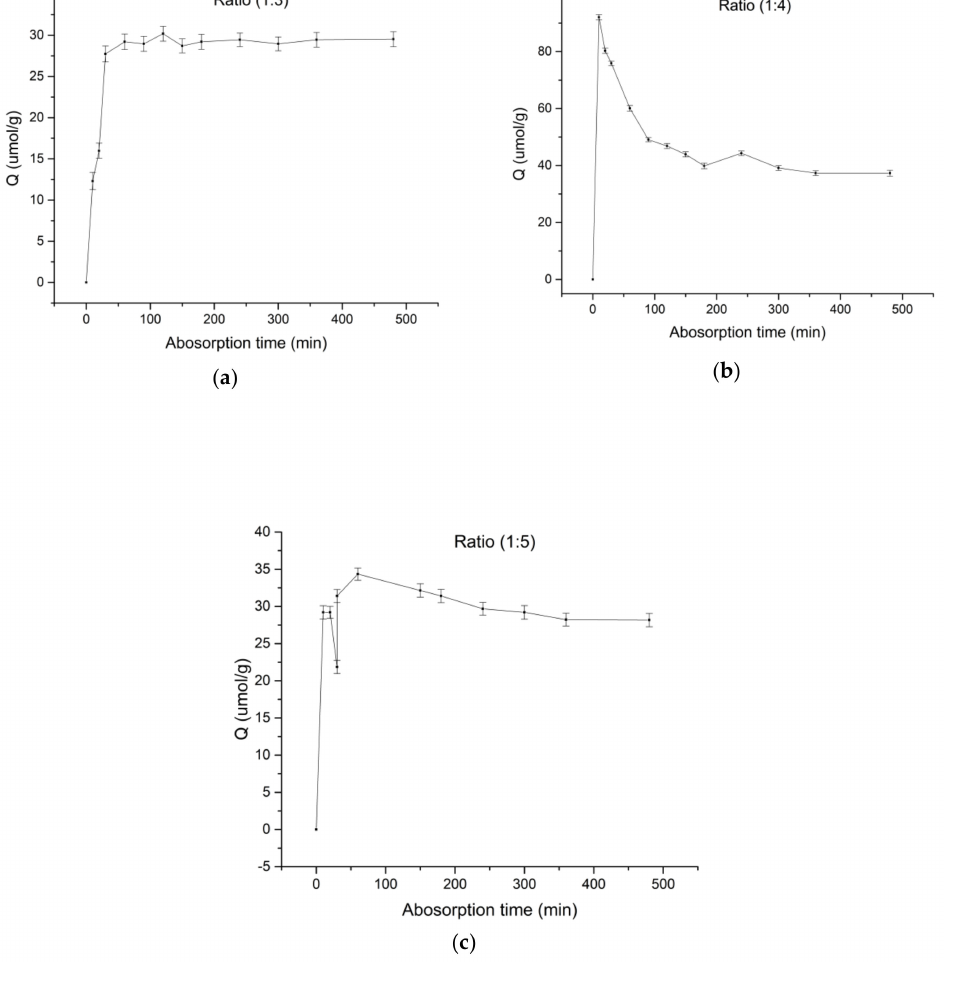
Figure 2. Curves of the binding dynamics of the three MIPs. ( a ) Ratio = 1:3, ( b ) ratio = 1:4, ( c ) ratio = 1:5 (at 25 ◦ C, constant temperature